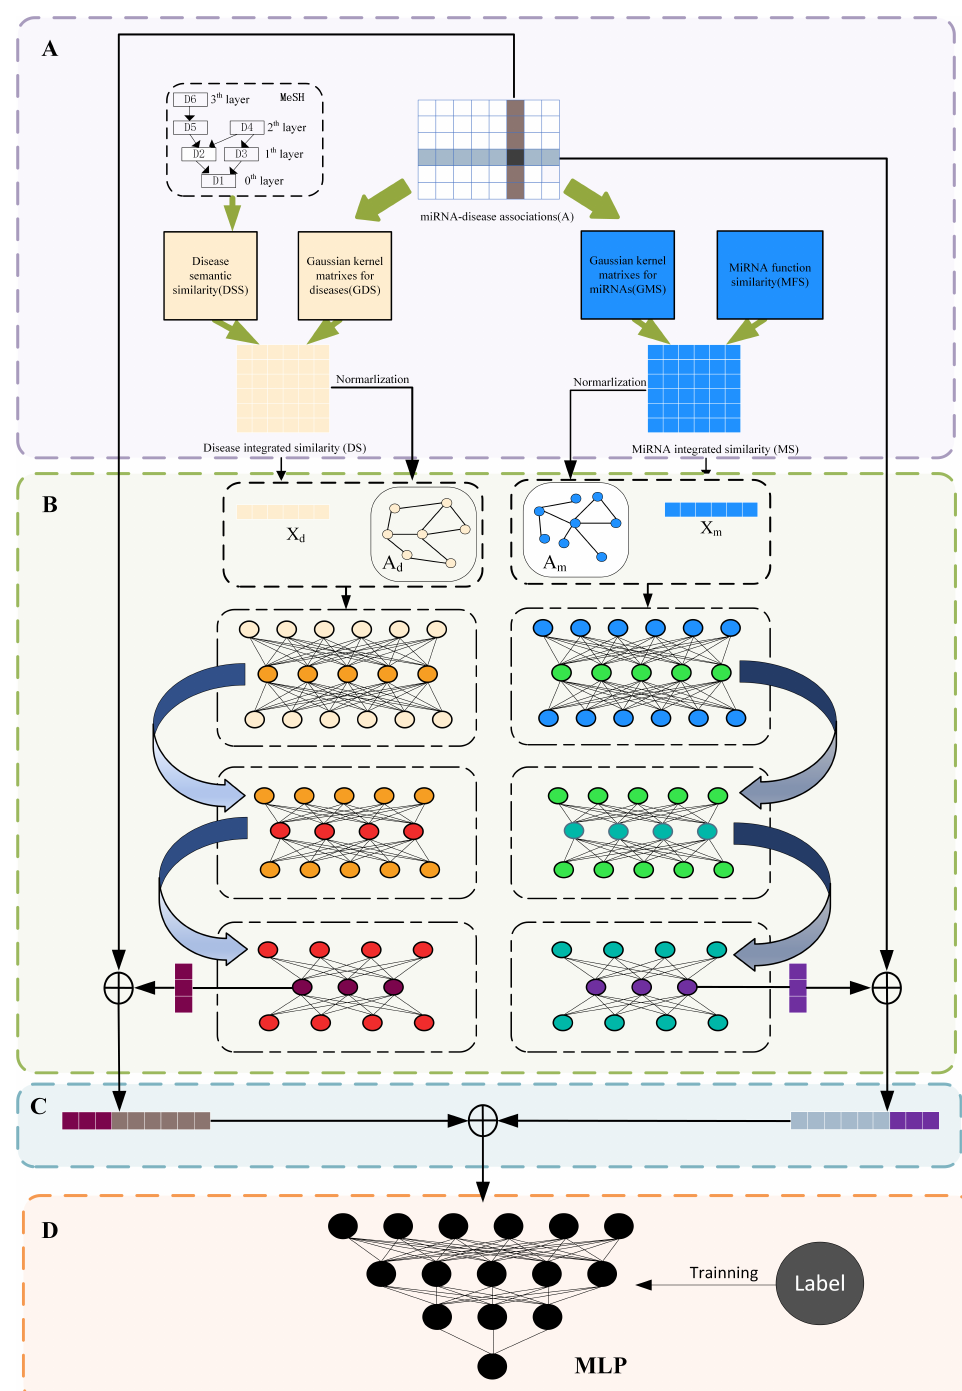
Figure 1. SGAEMDA flowchart. ( A ) Construction of initial features and data processing. ( B ) Pre- training to extract low-dimensional similarity features of miRNA and disease. ( C ) Fusion of learned miRNA and disease features to generate miRNA-disease pair feature vector. ( D ) Association predic- tion score by